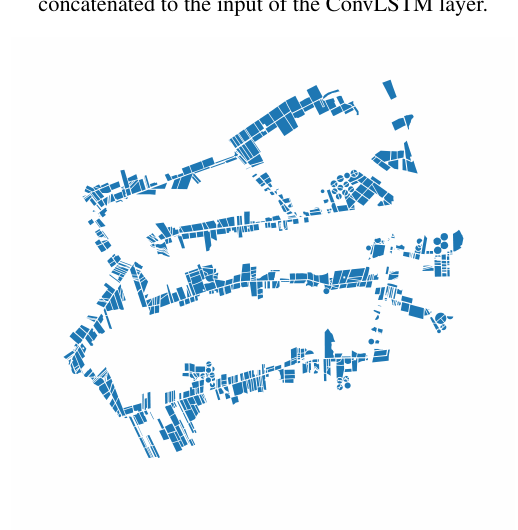
Table 3. Parameter configuration used in all experiments. T is the temporal sequence length, H and W indicate height and width, D is the input dimensionality, and C is the class number ( H =32, W =32, D =2, C =6). In VUnetConvLSTM, the day of the year was used as an additional input, which was concatenated to the input of the ConvLSTM layer.